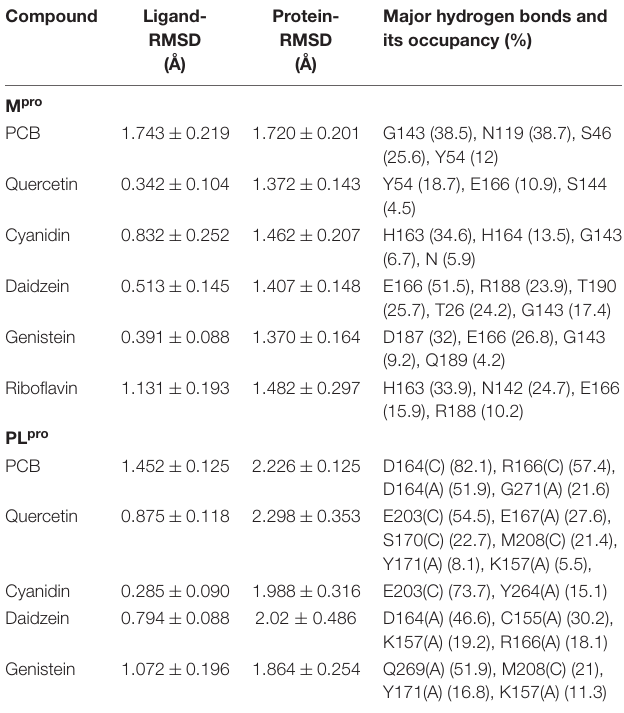
TABLE 3 | Average ligand and protein RMSD and occupancy of major hydrogen bonds for food bioactive compounds in traditional MD simulations. Compound Ligand-